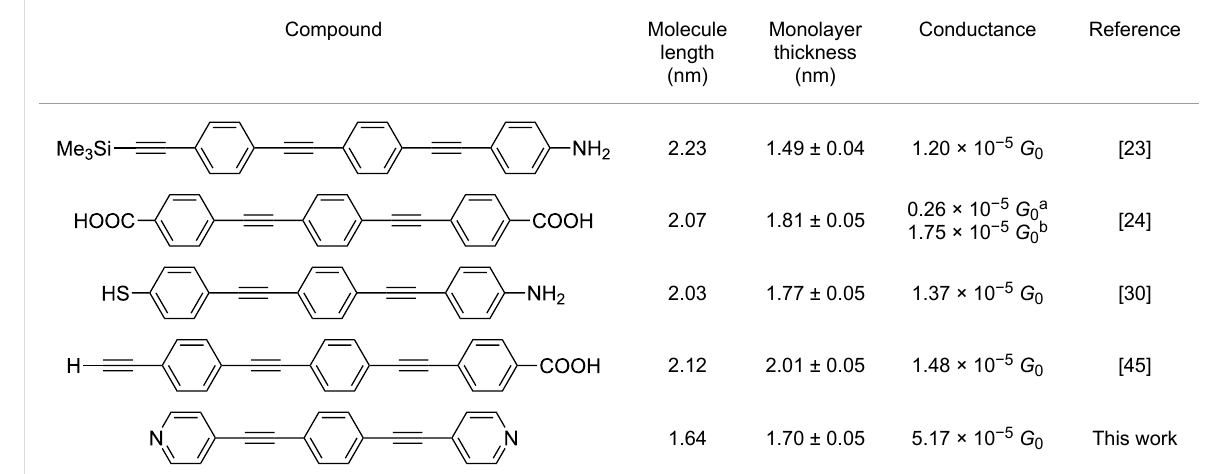
Table 1: Conductance values for the listed OPE compounds incorporated in monolayer LB films determined by using the “STM touch-to-contact” method. The length of the molecule, together with the monolayer thickness (which is a function of the molecule length, and the tilt angle of the molecule with respect to the substrate surface), are also